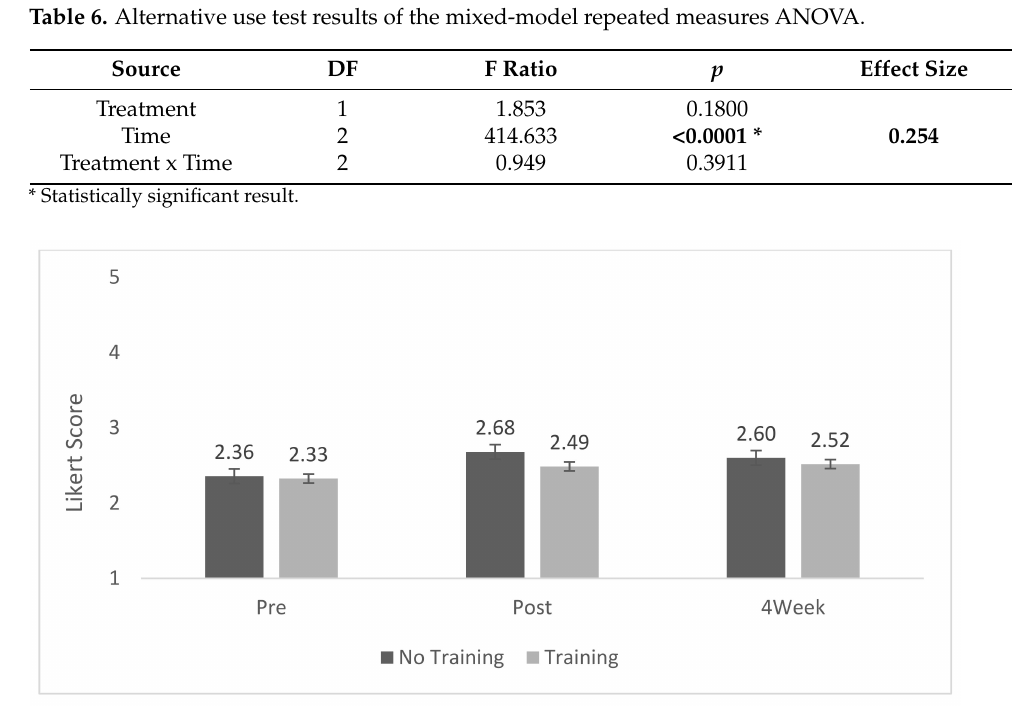
Figure 5. Alternative use test mean